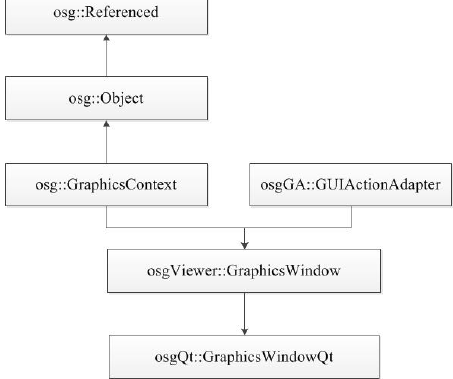
Figure 4. The inheritance of osgViewer::GraphicsWindowQt